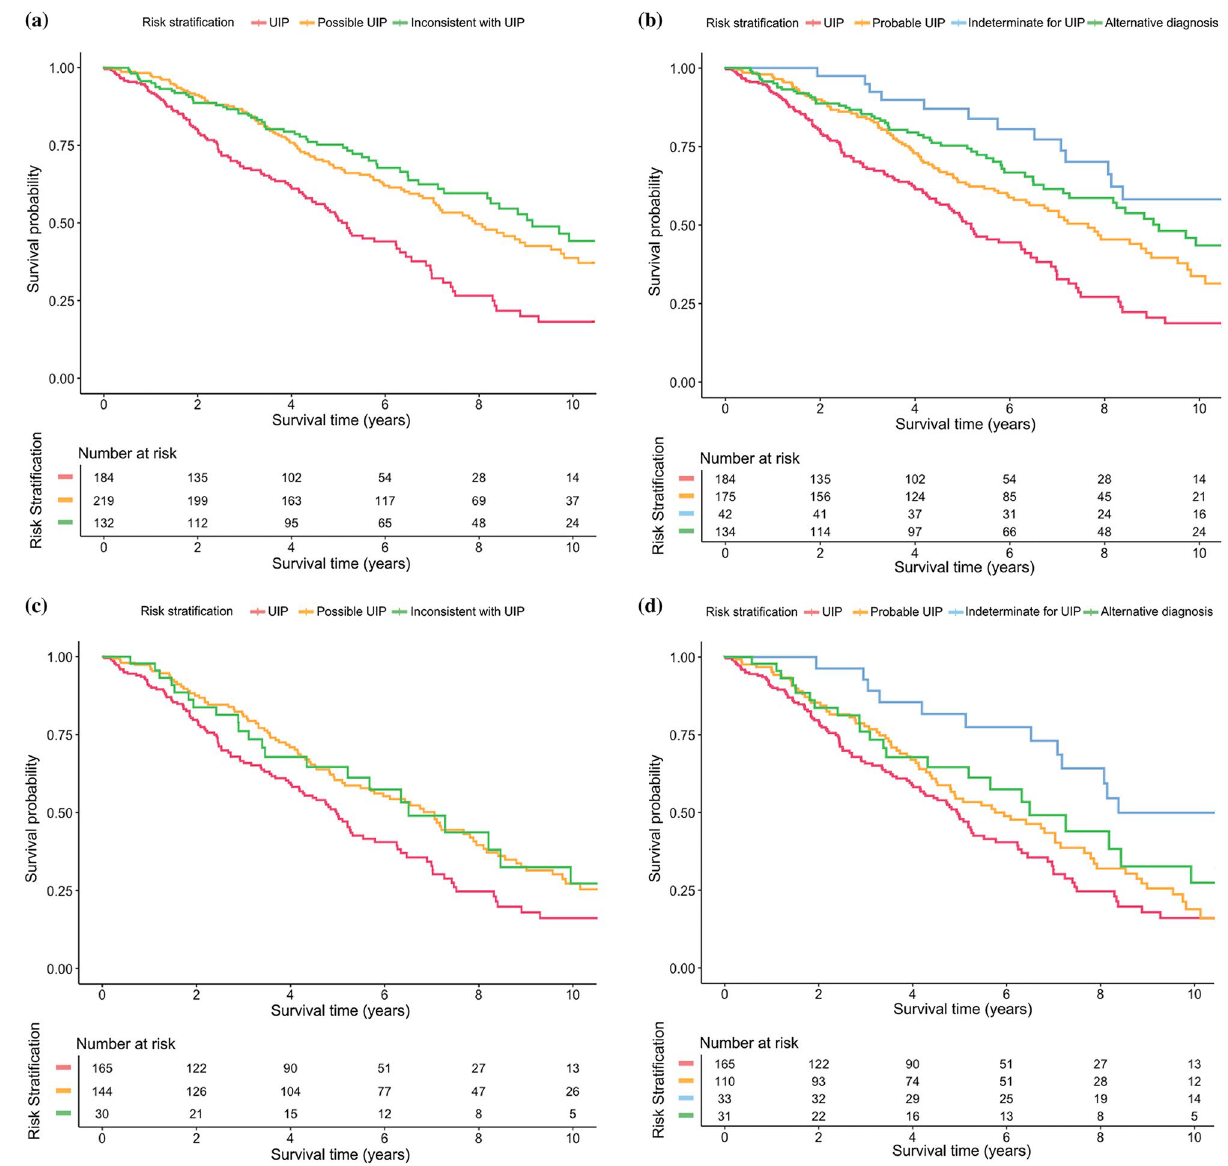
Figure 2. Adjusted survival curves of overall survival stratified according to the CT patterns of 2011 and 2018 guidelines for diagnosis of idiopathic pulmonary fibrosis. (a , b ) Patients with fibrosing interstitial lung disease (total cohort) and ( c , d ) patients with idiopathic pulmonary fibrosis as a function of CT pattern according to the 2011 and 2018 diagnostic criteria, respectively. Survival curves were adjusted by age, sex, baseline forced vital capacity, diffusing capacity of the lung for carbon monoxide and use of